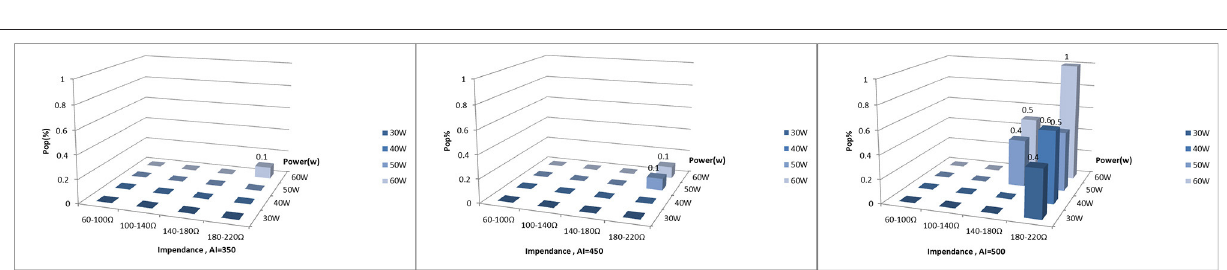
FIGURE 5 | Variations in the lesion characteristics during baseline R changes (low impedance = 80–100 (cid:127) , medium impedance = 100–140 (cid:127) , high impedance = 140–180 (cid:127) , and very high impedance = 180–220 (cid:127) ) when P = 30W and AI = 350. Each box represents the interquartile range (IQR) of each measure, with the middle horizontal line representing the median. The vertical lines denote the minimum and maximum values. The symbols denote whether these changes are statistically significant: “*” means p < 0.05 and “#” means p > 0.05.